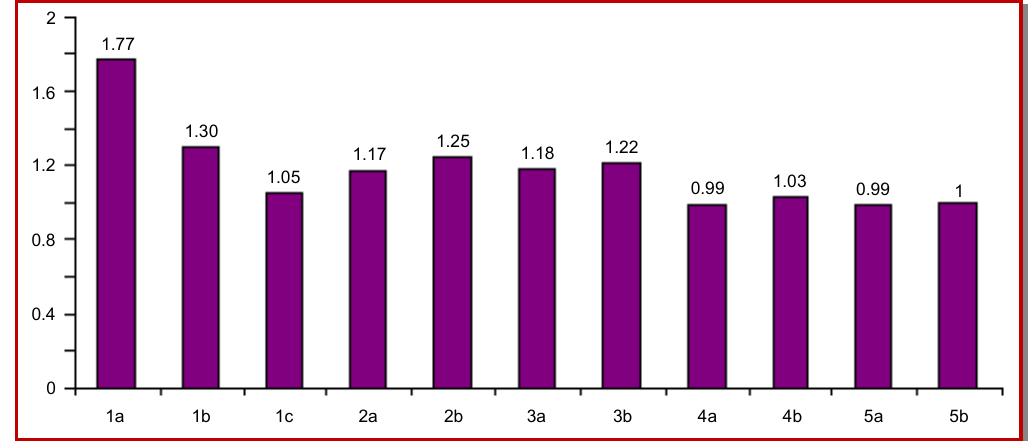
Figure 1: LC 50 values of the synthesized compounds 1a –